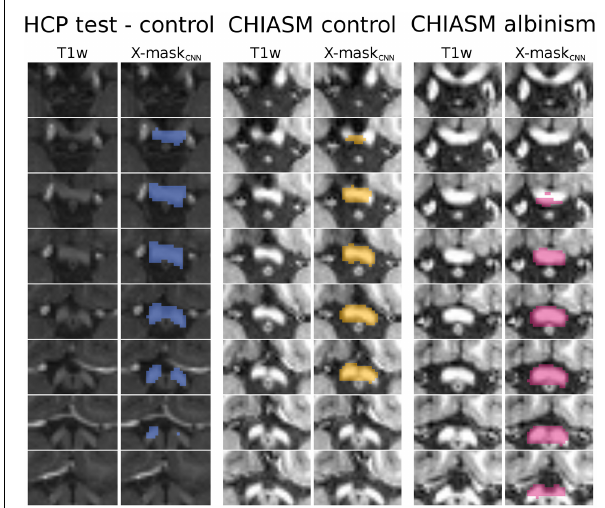
FIGURE 5 | Overview of X-mask CNN from a representative HCP test-control, CHIASM control, and CHIASM albinism participant. Axial slices display the optic chiasm region on the T1w image; blue-, yellow-, and magenta-colored masks show the X-mask CNN defined for the HCP test-control, CHIASM control, and CHIASM albinism participants, respectively (marked by a black edge on Figure 4 ).